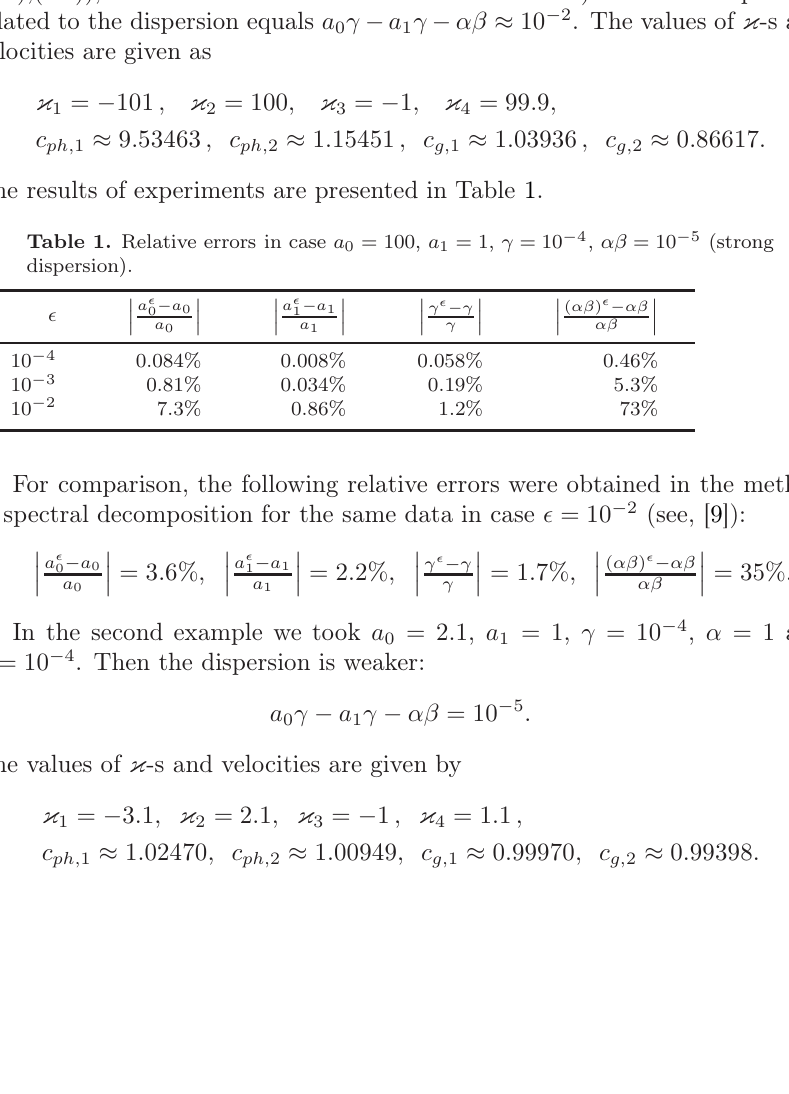
Table 1. Relative errors in case a